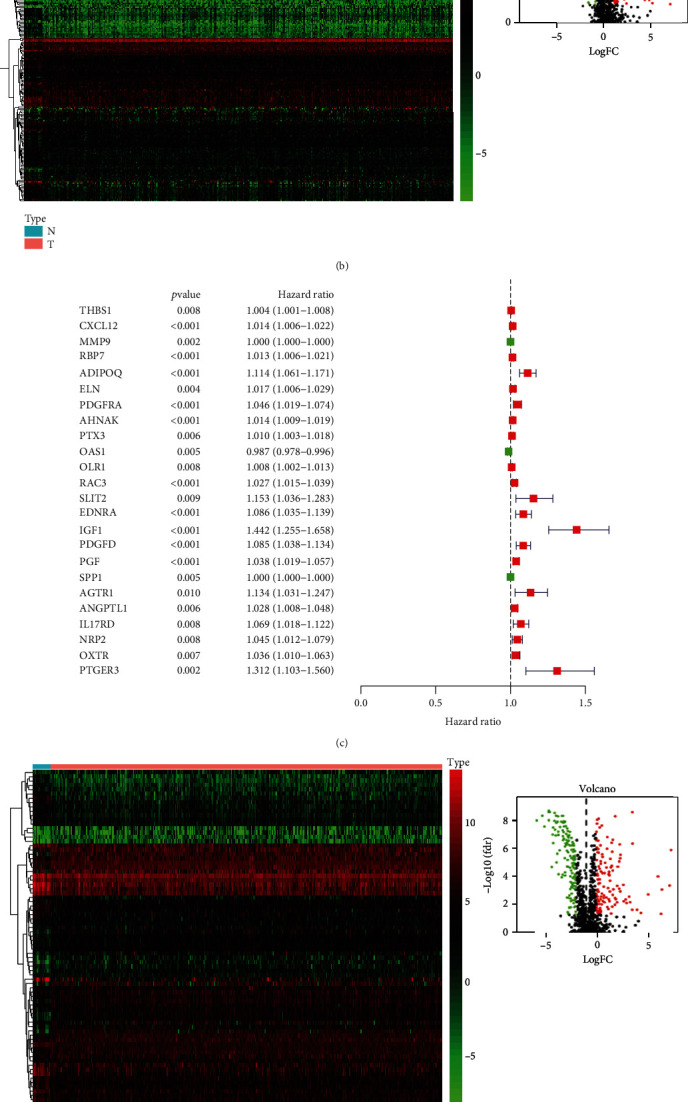
Heatmap and volcano of (a) differential genes, (b) differential immune-related genes, and (c) differential TFs between tumor and normal samples. Forest plots of hazard ratios of 24 immune-related genes with prognostic ability (d). Network of interaction between differential immune-related genes and TFs (e).